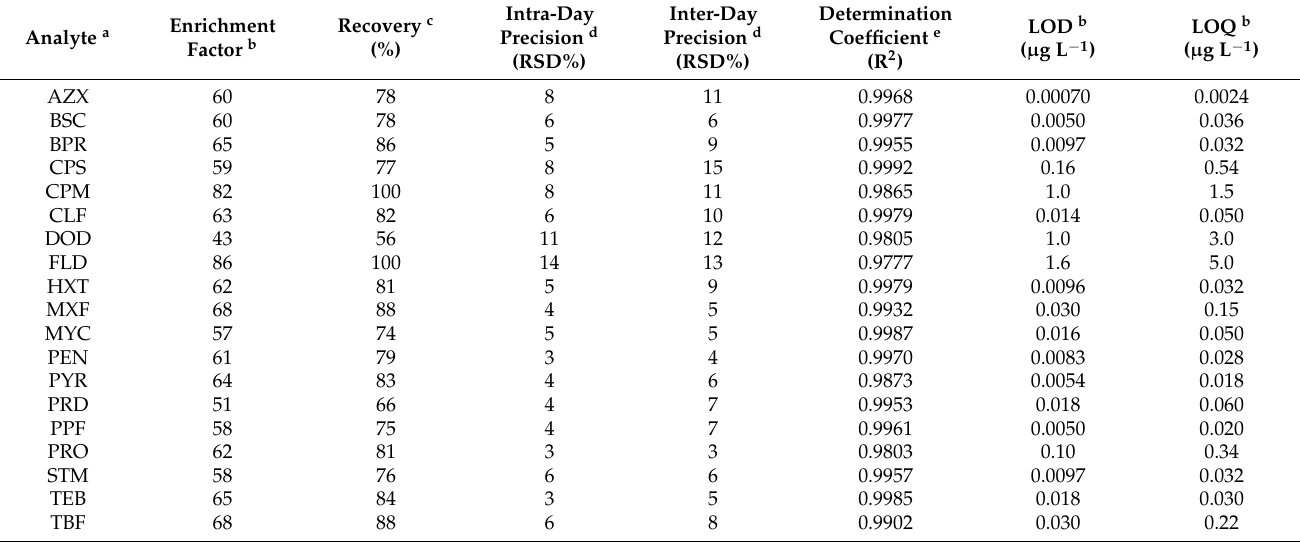
Table 2. Main figures of merit of the validated DLLME/HPLC-MS